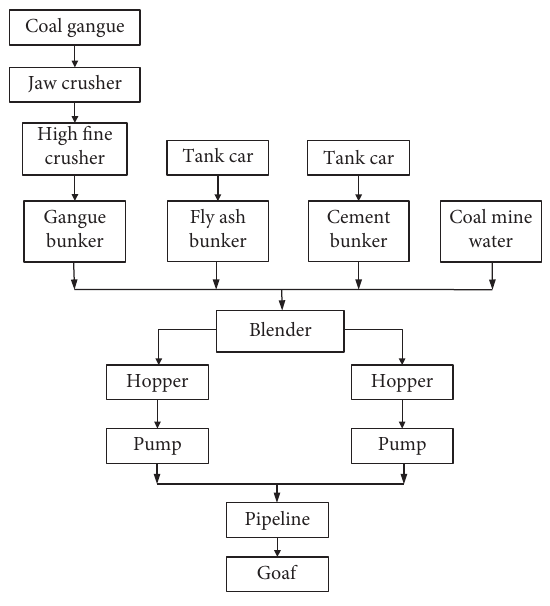
Figure 6: Field preparation process of